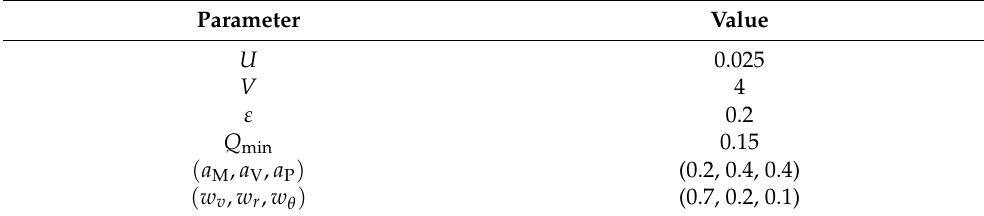
Table 2. The parameters set for the proposed method in the